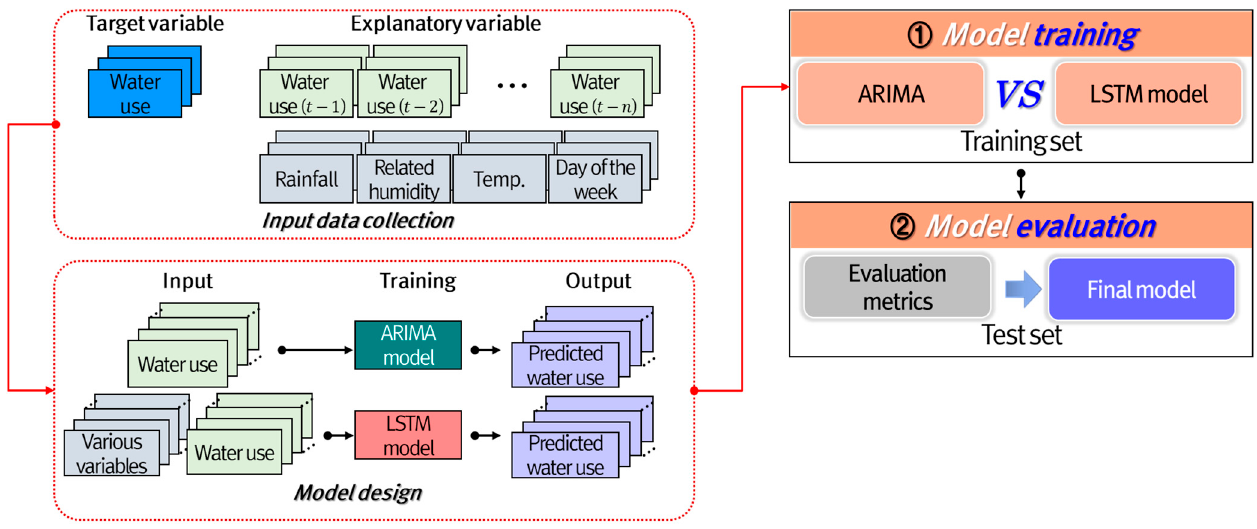
Figure 4. Flow chart for this study.